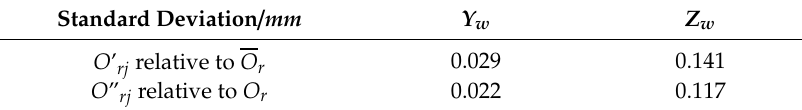
Table 4. The standard deviation in the Y w and Z w directions.